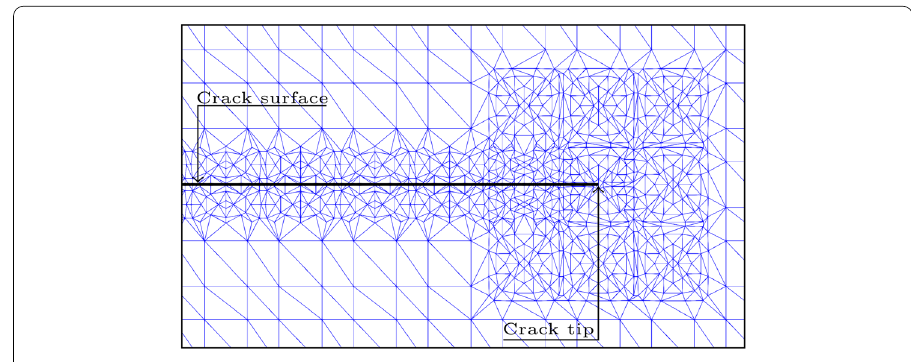
Fig. 2 Integration procedure used: sub-triangulation mesh formed from Gauss points generated around surface and tip of the